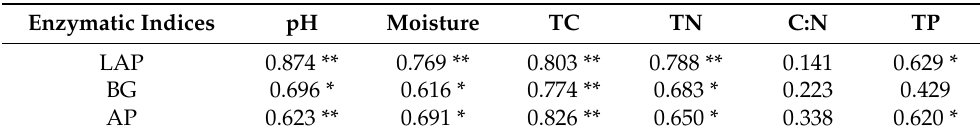
Table 2. Pearson’s correlation coefficients of sediment enzyme activities on the sediment properties in aquaculture ponds.